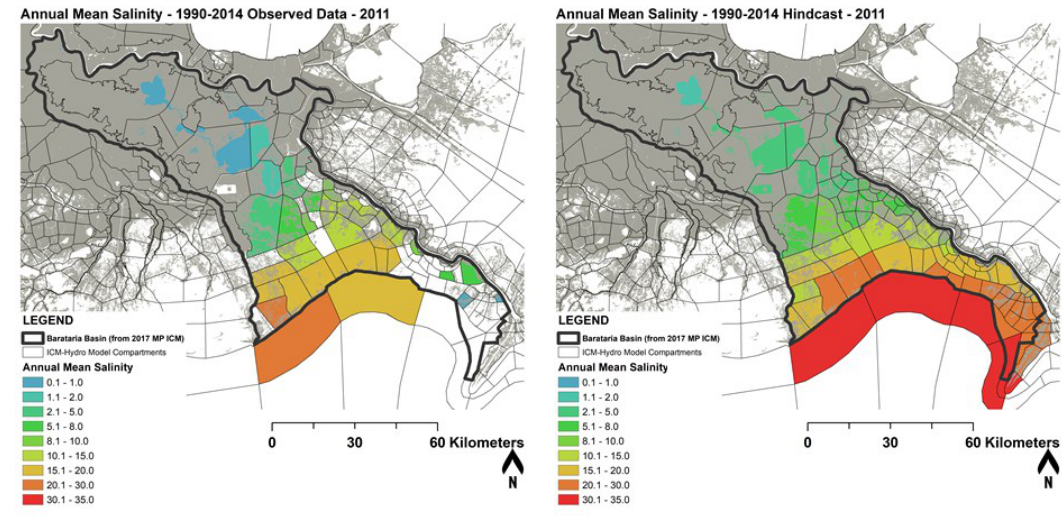
Figure 9. Observed ( left ) and modeled hindcast ( right ) mean annual salinity (ng/kg) averaged across ICM-Hydro model compartments for a higher-than-average river year (2011). Refer to Figures S1 and S2 in Supplementary Materials for additional years.